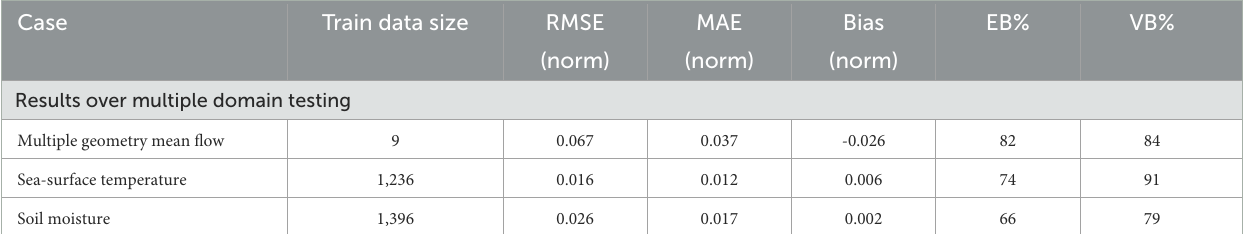
An estimate of the epistemic uncertainty of the model was